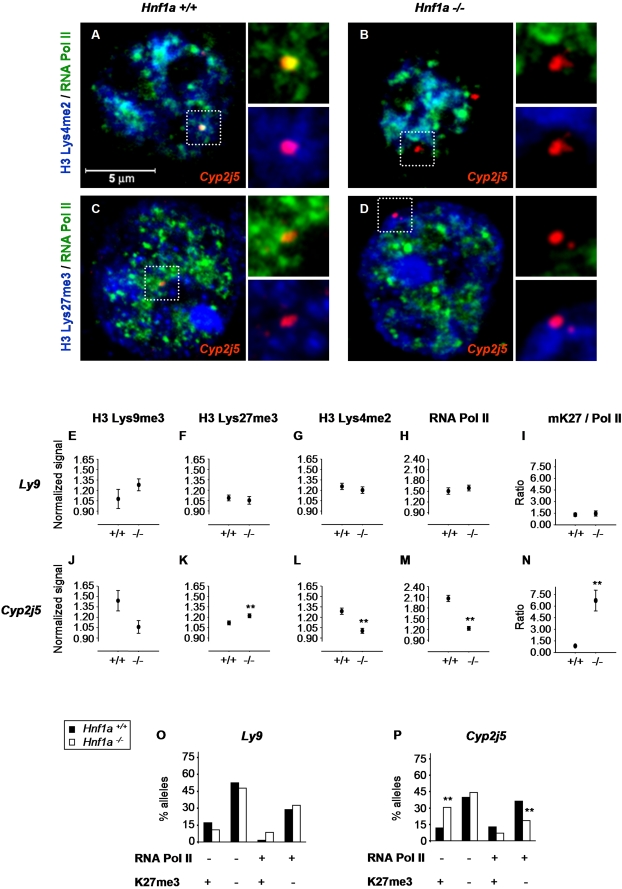
Hnf1α-dependent Cyp2j5 activity correlates with differential positioning in RNA polymerase II and histone code domains.(A–D) Representative confocal immuno-FISH analysis in Hnf1a+/+ and Hnf1a−/− hepatocytes of the Cyp2j5 locus (red) with RNA polymerase II (RNA Pol II, green) and either H3-Lys4me2 (A,B) or H3-Lys27me3 (C,D) (blue). The framed regions containing Cyp2j5 FISH signals are shown at higher magnification on the right of each panel with omission of blue or green channels (E–N) Quantitative analysis of histone marks and RNA polymerase II in Cyp2j5 (J–N) and Ly9 control (E–I) loci in Hnf1a+/+ and Hnf1a−/− hepatocytes. For each condition, non-thresholded fluorescence intensities of histone marks and RNA polymerase II were measured at 70–200 FISH signals, and each value was divided by its nuclear median intensity in the same channel. The graphs thus depict the average of such normalized signal values±SEM, except in I,N which shows mean±SEM of H3-Lys27me3/RNA polymerase II ratios (mK27/Pol II) calculated for each allele. (O–P) Classification of Cyp2j5 (P) and Ly9 control (O) alleles into 4 categories according to the simultaneous enrichment (+) or non-enrichment (−) of RNA polymerase II (RNA Pol II) and H3-Lys27me3 (K27me3) in Hnf1a+/+ (black bars) and Hnf1a−/− (white bars) hepatocytes. Each allele was scored as enriched (+) or non-enriched (−) based on whether or not the signal intensity exceeded the 75th percentile of nuclear signals. Alternate thresholds such as the nuclear median yielded comparably significant results (see text). Results are expressed as % of all alleles for each genotype. *p<0.05 and **p<0.01 relative to Hnf1a+/+ cells using Mann-Whitney or Fisher's exact test as appropriate.